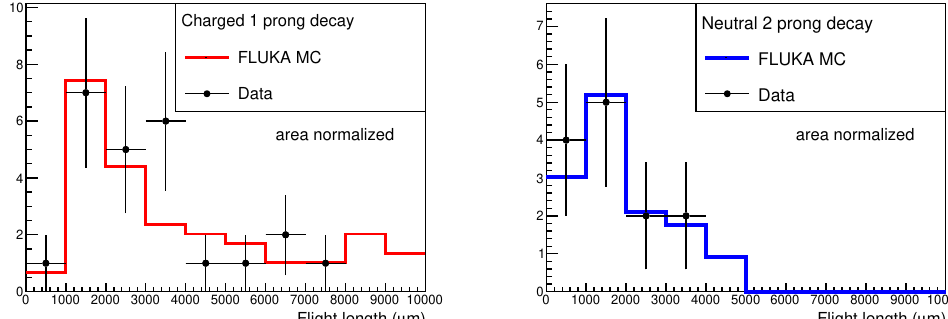
Figure 19 . Flight length distributions for charged 1-prong and neutral 2-prong decay candidates in the double-charm event samples. The FLUKA MC histograms are area-normalized to data. are selected by applying the criteria equivalent to those described in table 1. This search is meant to detect (cid:28) decay in D ! (cid:28) ! X and the partner charm particle can be s